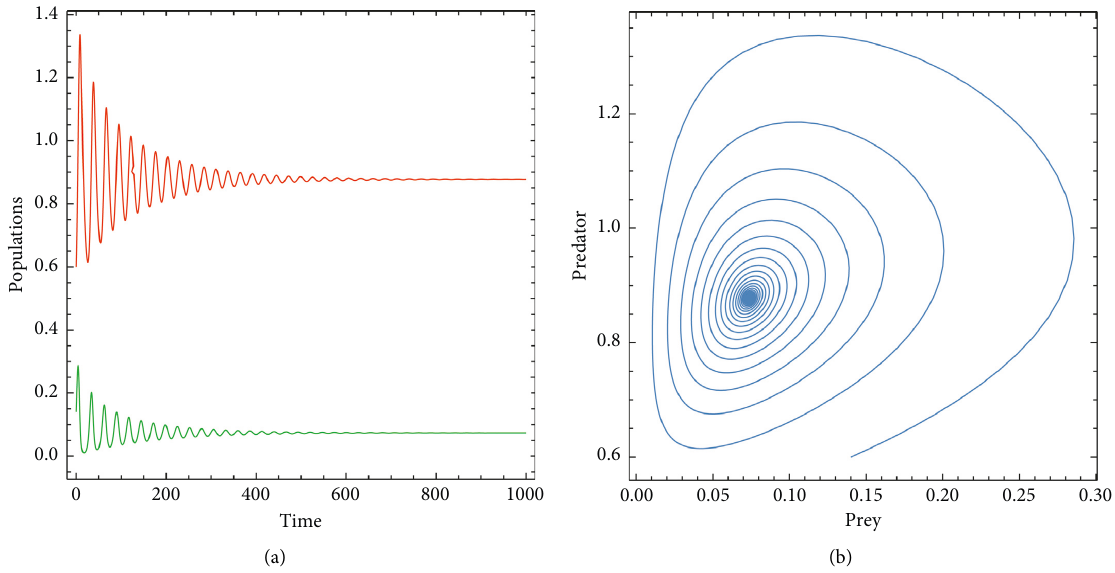
Figure 4: Locally asymptotically stable. (a) Time plot; (b) phase portrait for the model (51) with m